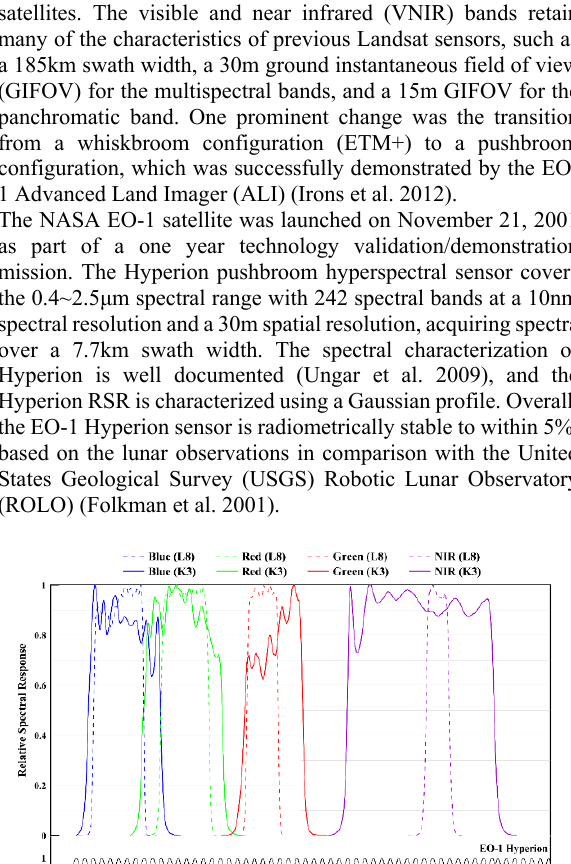
Table 2. Metadata of images in this study